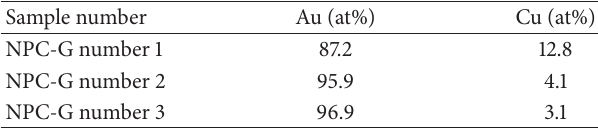
Table 2: Chemical compositions of the NPC-G samples test by